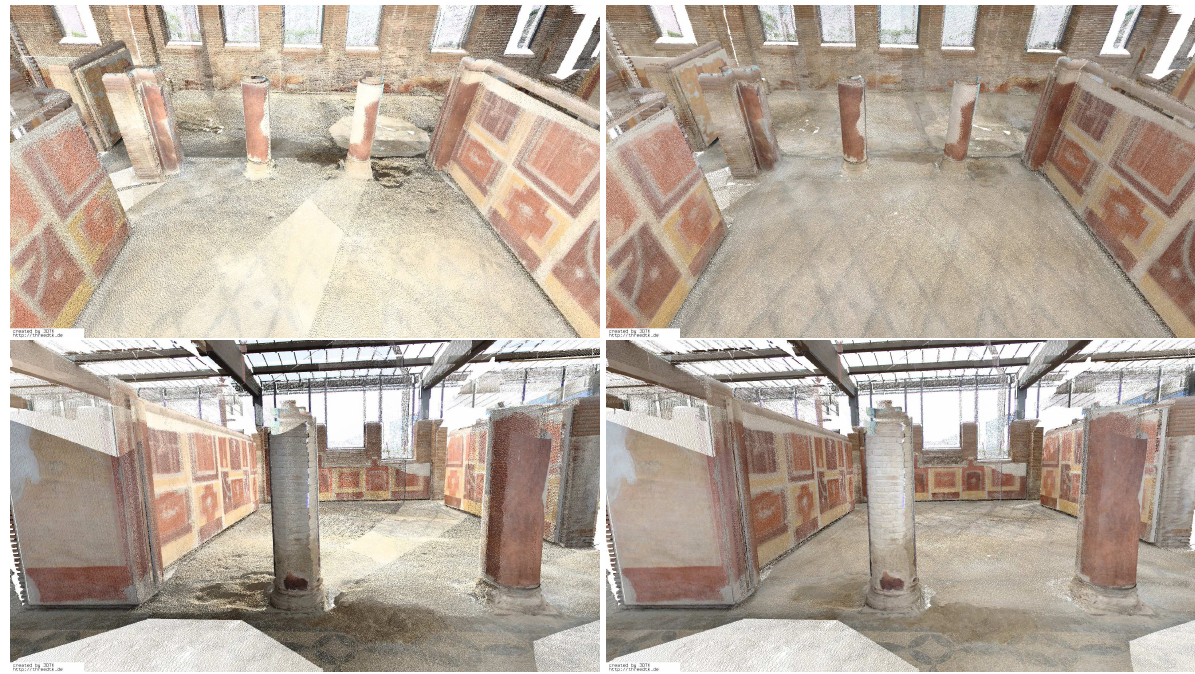
Figure 7. Ostia Antica. Details from point cloud before (left) and after optimization (right). Over- and underexposed images are aligned, therefore the homogeneity in brightness distribution increased. The point density is exactly the same for all